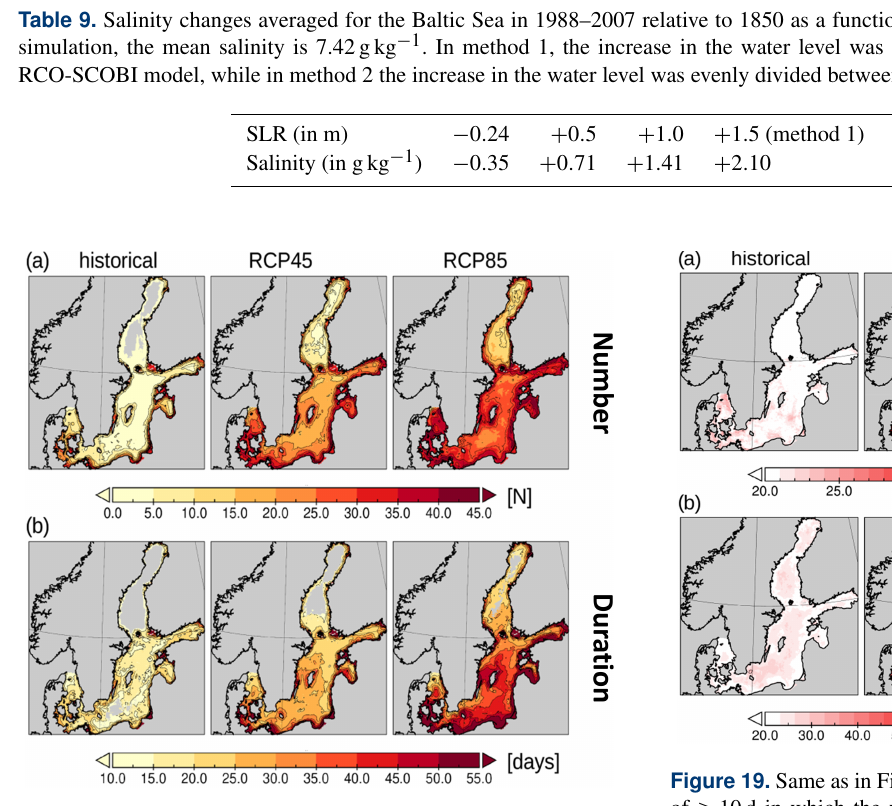
Figure 18. (a) Number of heat waves (defined as the number of periods ≥ 10d in which the water temperature is ≥ 20 ◦ C) for his- torical (1976–2005) and future (2069–2098) climates. (b) Average duration of the heat waves. Note that no temperature bias adjust- ment was done prior to the analysis. Shown are the ensemble aver- ages of four different ESMs with the mean sea level rises (a) 0.54 m (RCP4.5) and (b) 0.90m (RCP8.5). (Data source: Meier et al., 2021.)